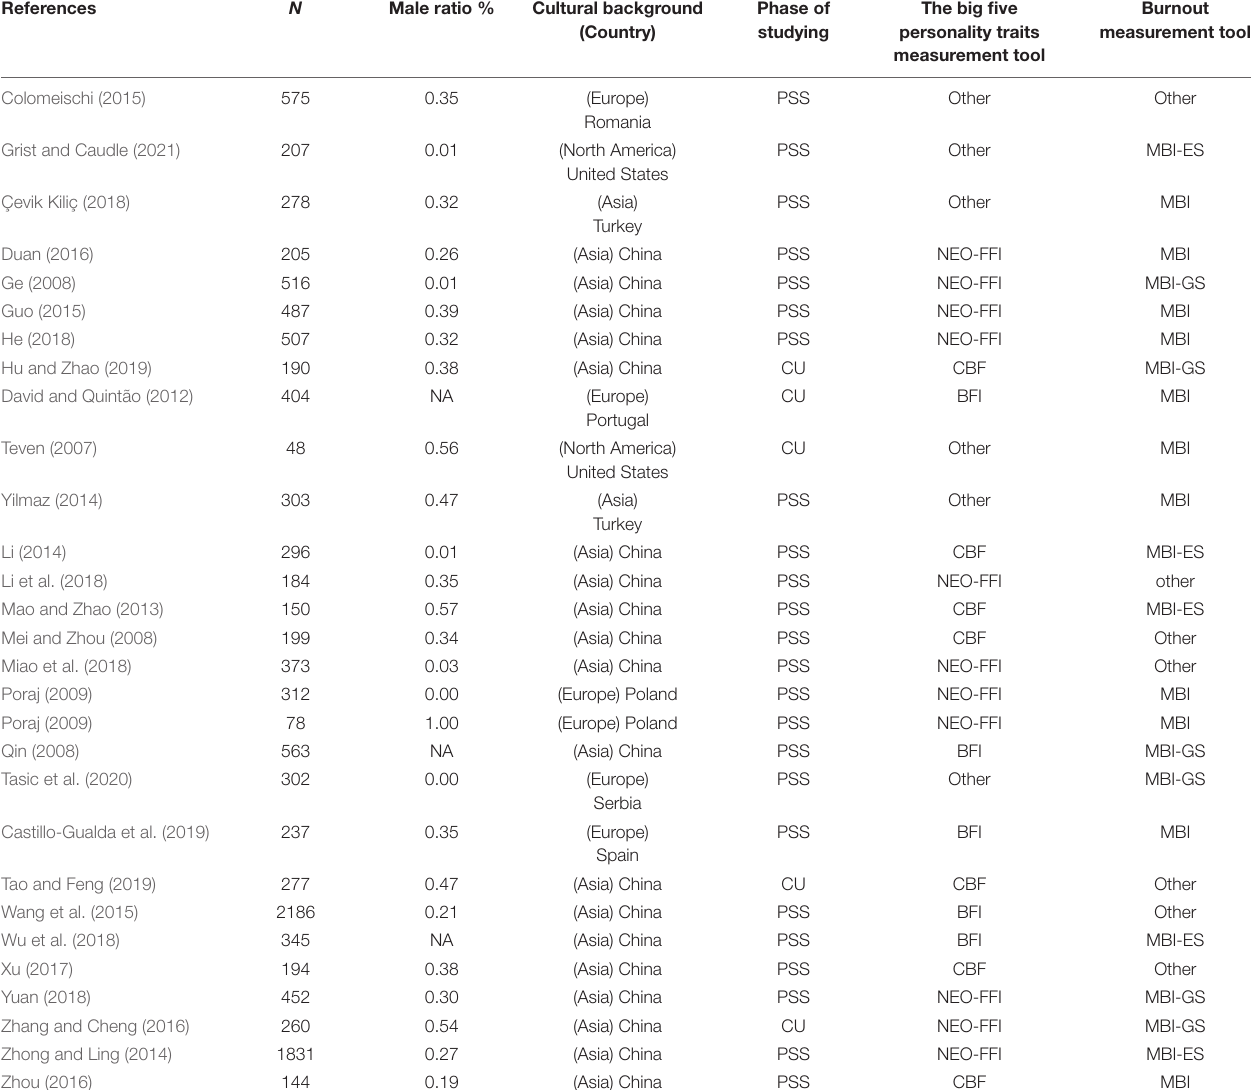
TABLE 1 | Studies included in the